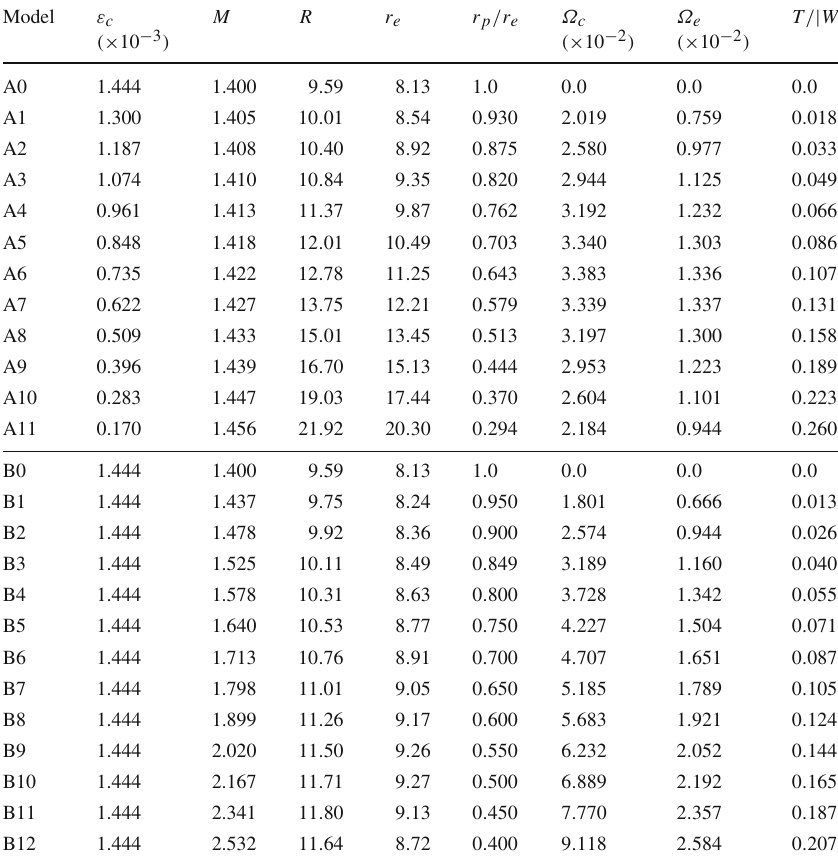
Table 4 Properties of two sequences of differentially rotating equilibrium models